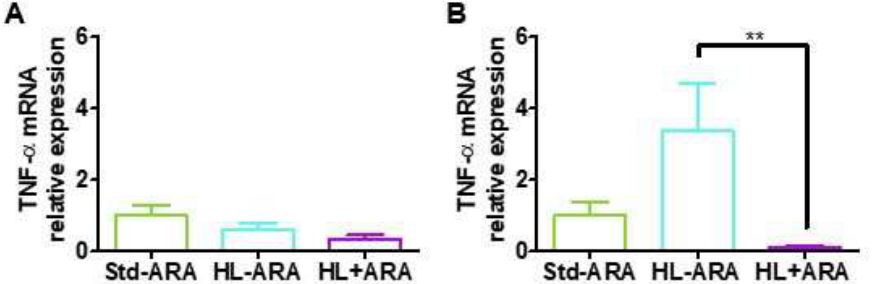
Figure 4. Gene expression of TNF-α in the liver ( A ) and mesenteric adipose tissue ( B ) at 9 weeks of diet. Data are represented as the mean ± standard error of the mean (SEM). n = 4–5 mouse per diet group. ** p < 0.01 compared with the standard diet. Data analyzed by one-way ANOVA test and Bonferroni’s multiple comparisons test for post hoc analysis.